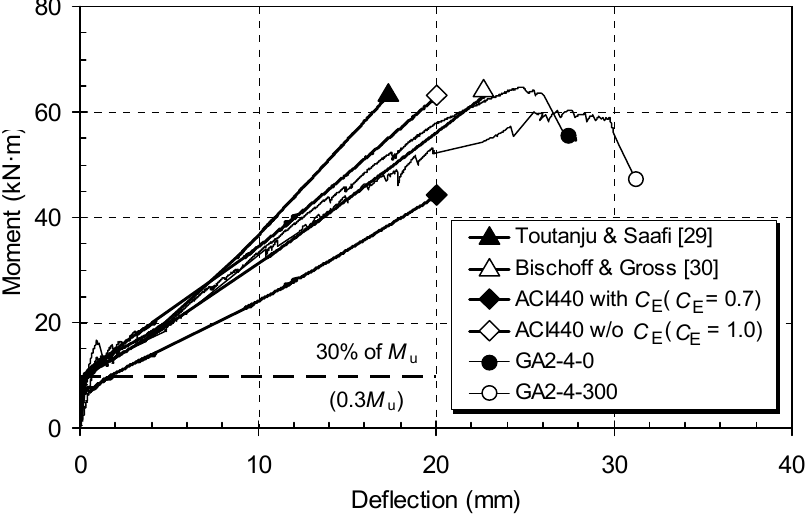
Figure 6. Comparison of predicted and measured results in the GA2-4